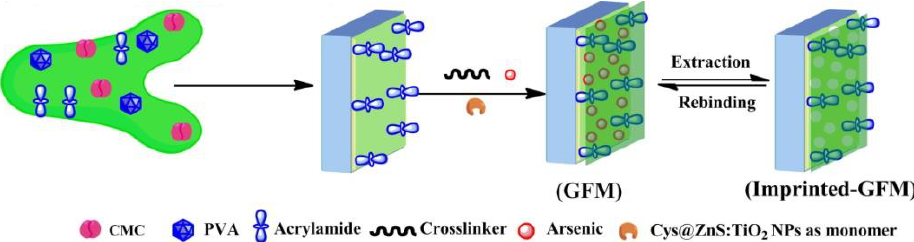
Figure 2. Graphical representation for the fabrication of imprinted membrane synthesized via ‘grafting-from’ (GFM) approaches. Reprinted with permission from ref [34]. Copyright 2016 American Chemical Society.